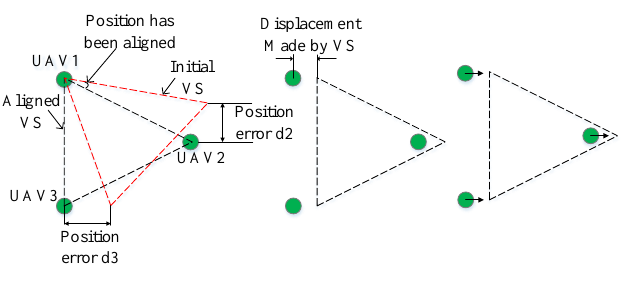
Figure 10. Virtual Structure control